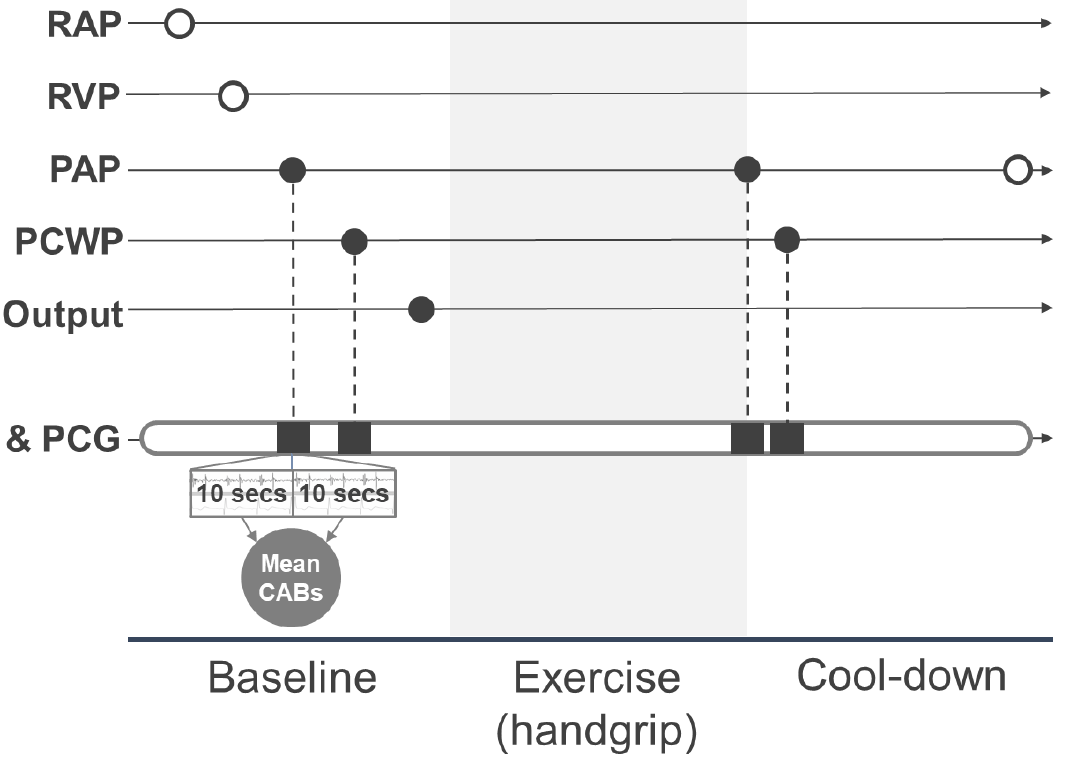
Figure 1. Measurement workflow for simultaneous recording of right heart catheterization and CABs. Filled circles represent the hemodynamic parameters used in the analysis. White circles represent the hemodynamic parameters not used in the analysis. RAP, right atrial pressure; RVP, right ventricular pressure; PAP, pulmonary artery pressure; PCWP, pulmonary capillary wedge pressure; ECG, electrocardiogram; PCG, phonocardiogram; CABs, cardiac acoustic biomarkers.